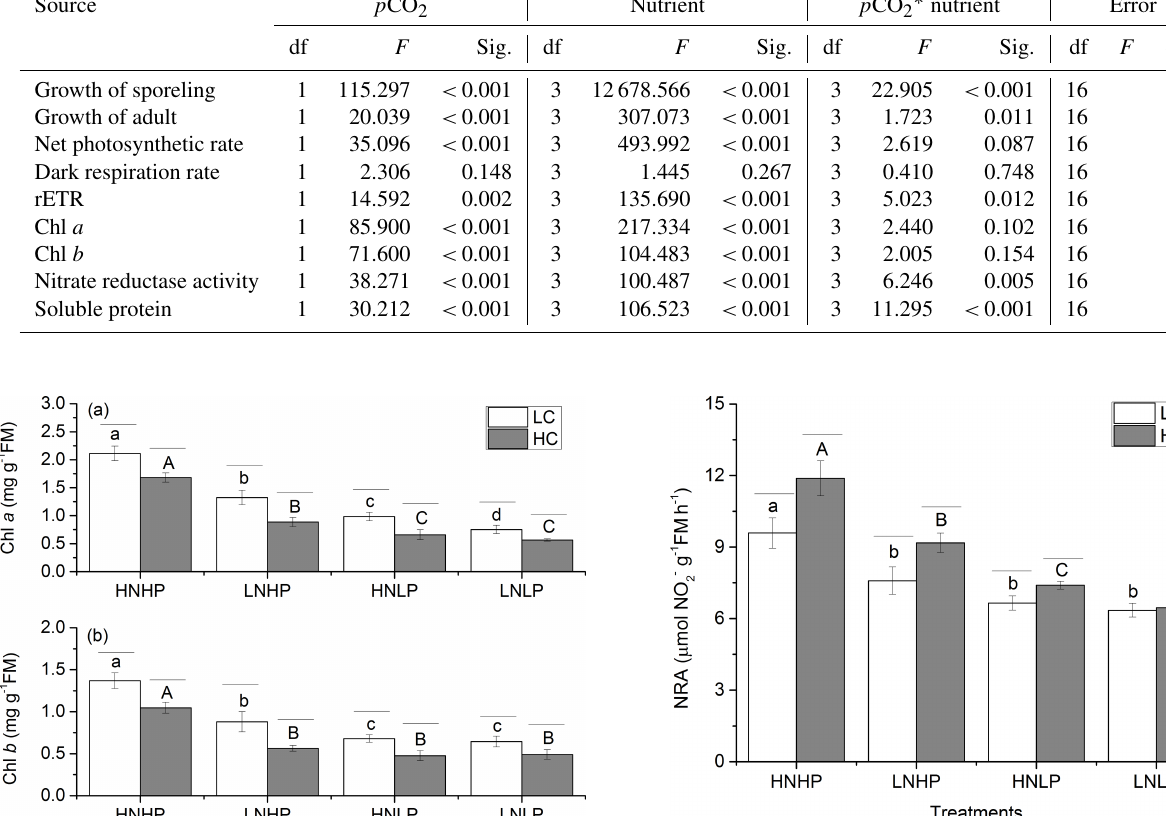
Table 4. Two-way analysis of variance for the effects of p CO 2 and nutrients on physiological parameters of U. linza ; p CO 2 ∗ nutrients means the interactive effect of p CO 2 and nutrients, df means degree of freedom, F means the value of F statistic, and Sig. means p value. Source